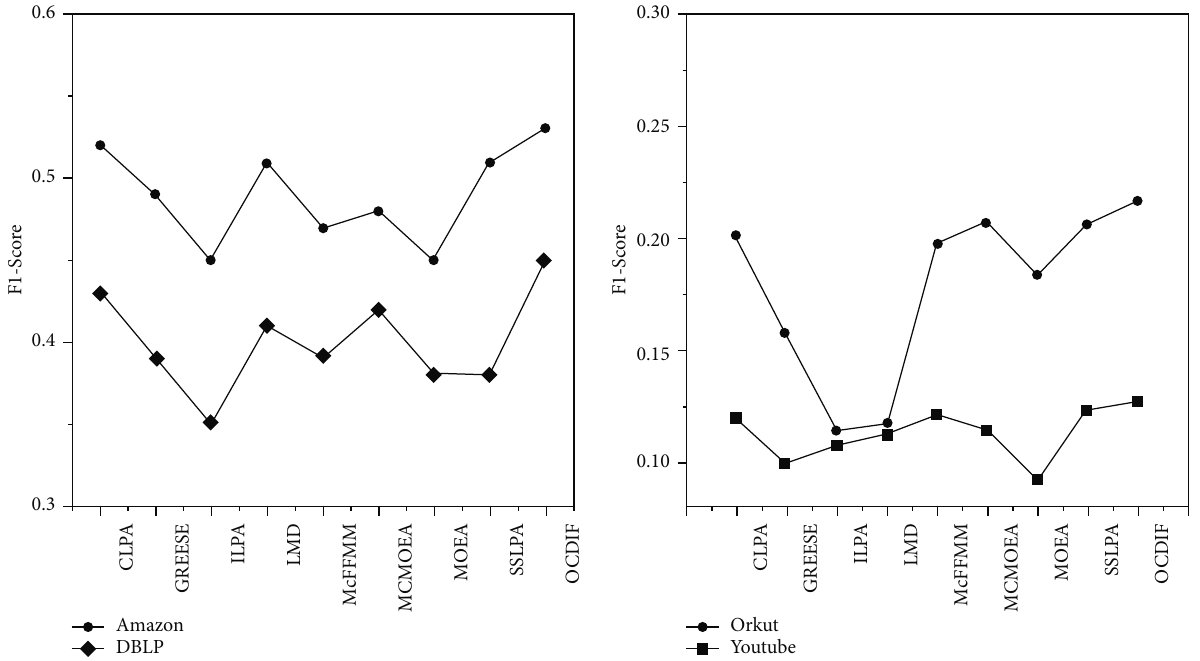
Figure 6: Average F1 value on